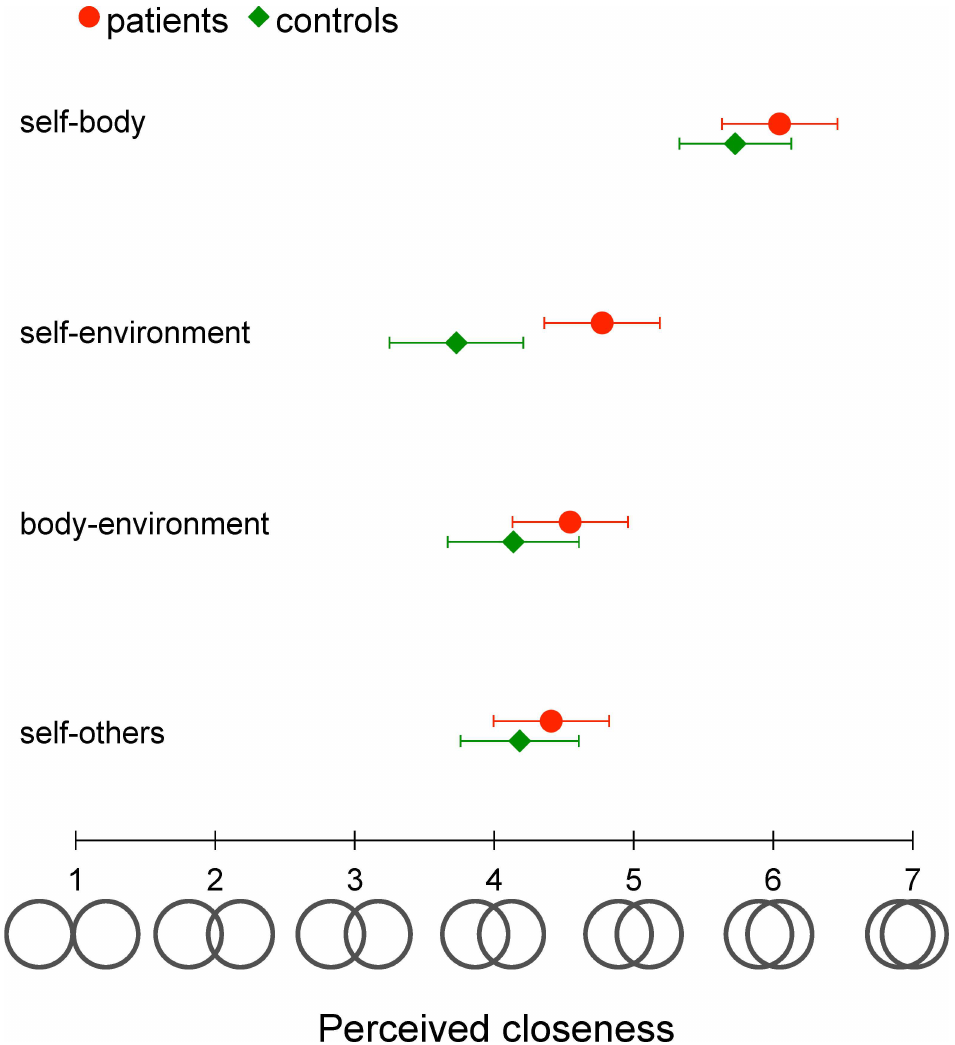
Fig 6. Subjective measuresof self-body anchoring (Experiment 3). Pictorial descriptions used to measurethe closeness betweenthe self, body, environment and others. Seven pairs of circles shown at the bottom of the figure were presented to participants, who had to indicate which one better represented the perceiveddegreeof “closeness” betweentwo items, such as the self and body. Coloredsymbols represent the mean of self-reportsfrom patients and controls and horizontalbars represent the standard error of the